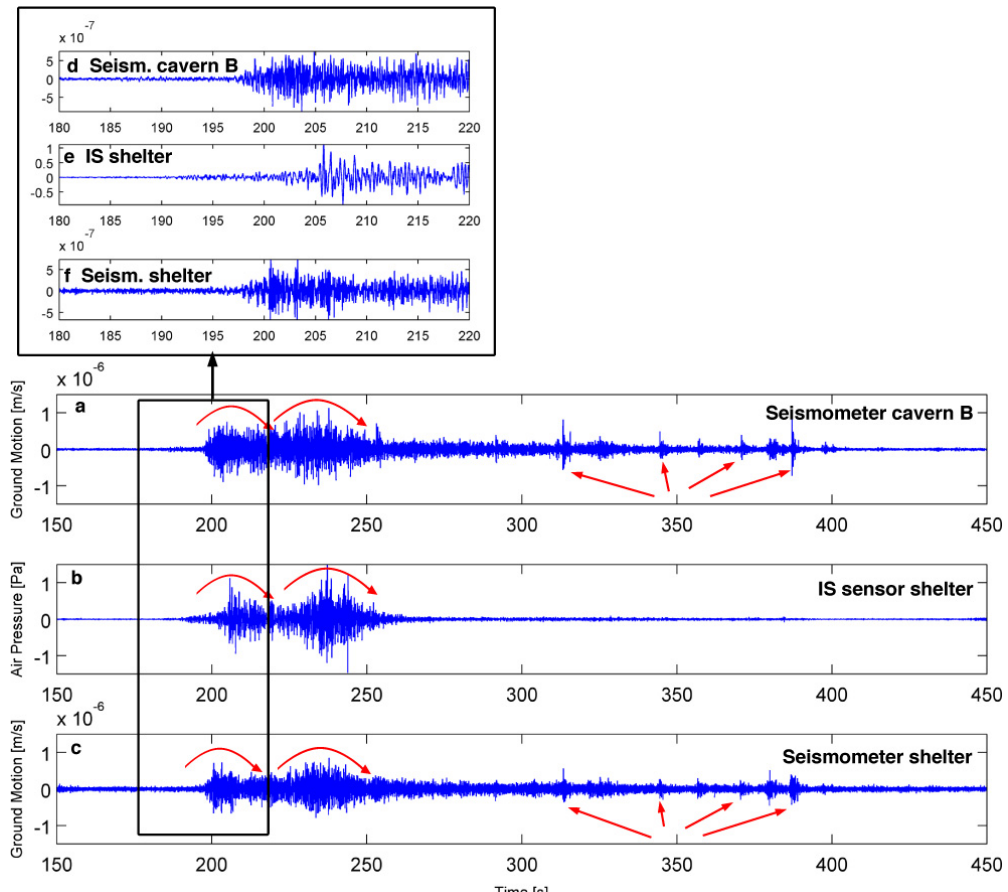
Fig. 9. Seismic (N-S component) and infrasonic data from Avalanche 2. Signals are represented with a common base of time. (a) Seis- mogram in caverns B; (b) infrasound time series near the shelter; (c) Seismogram near the shelter; (d) magnified Seismogram in cavern C; (e) magnified infrasound time series; and (f) magnified Seismogram near the shelter. Curved arrows indicate two different surges of the avalanche and straight arrows indicate the seismic peaks associated with the stopping phase of the